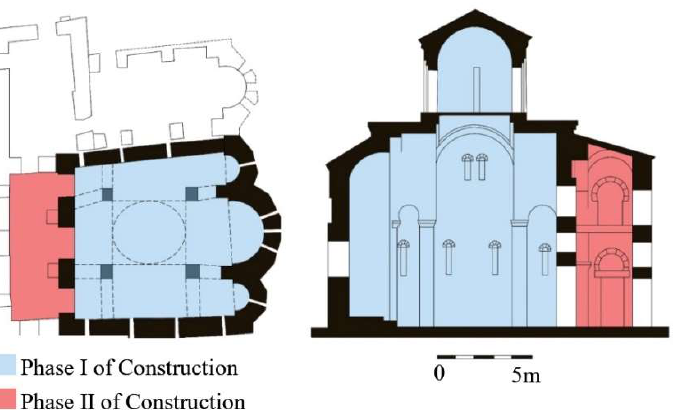
Figure 3. Plan and section drawings of the Bell Church showing its two phases of construction. Drawn by the authors based on the drawings from Ousterhout [22], pp. 92, 94.